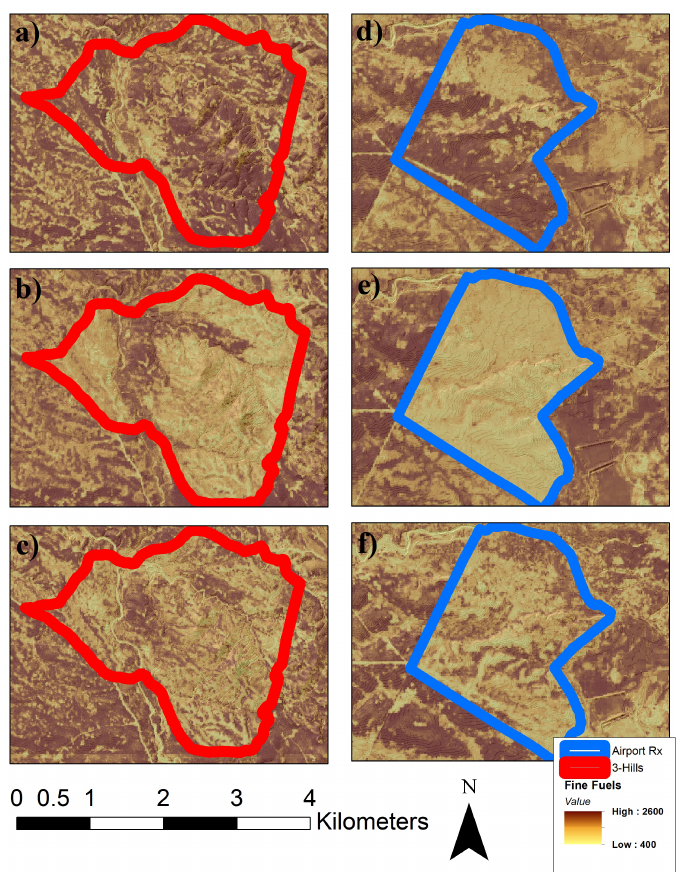
Figure 5. Change in fine-fuels associated with 3-Hills wildfire (red polygons) in July 2016 and the Airport prescribed fire (blue polygons) in June 2016 within BANWR based on Sentinel-2A estimates of fine-fuels showing ( a , d ) pre-fire year, ( b , e ) first-year post fire, and ( c , f ) fuel recovery in the third-year post